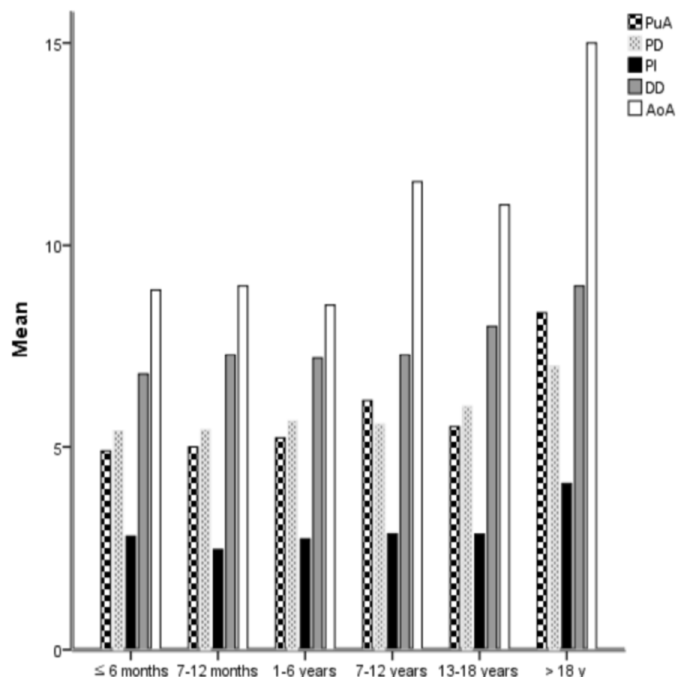
Figure 3. The size relationships between the regions of PDA and NOC; PI of PDA with other regions of PDA and NOC. It is useful to select the size of NOC by measuring the sizes of PI, PuA, and Ao according to chronological age. Ao; aorta, AoA; aortic ampulla of PDA, NOC; Nit-Occlud ® coil, PDA; patent ductus arteriosus, PuA; pulmonary ampulla of PDA, PI; PDA isthmus, DD; distal diameter of NOC, PD; proximal diameter of NOC.